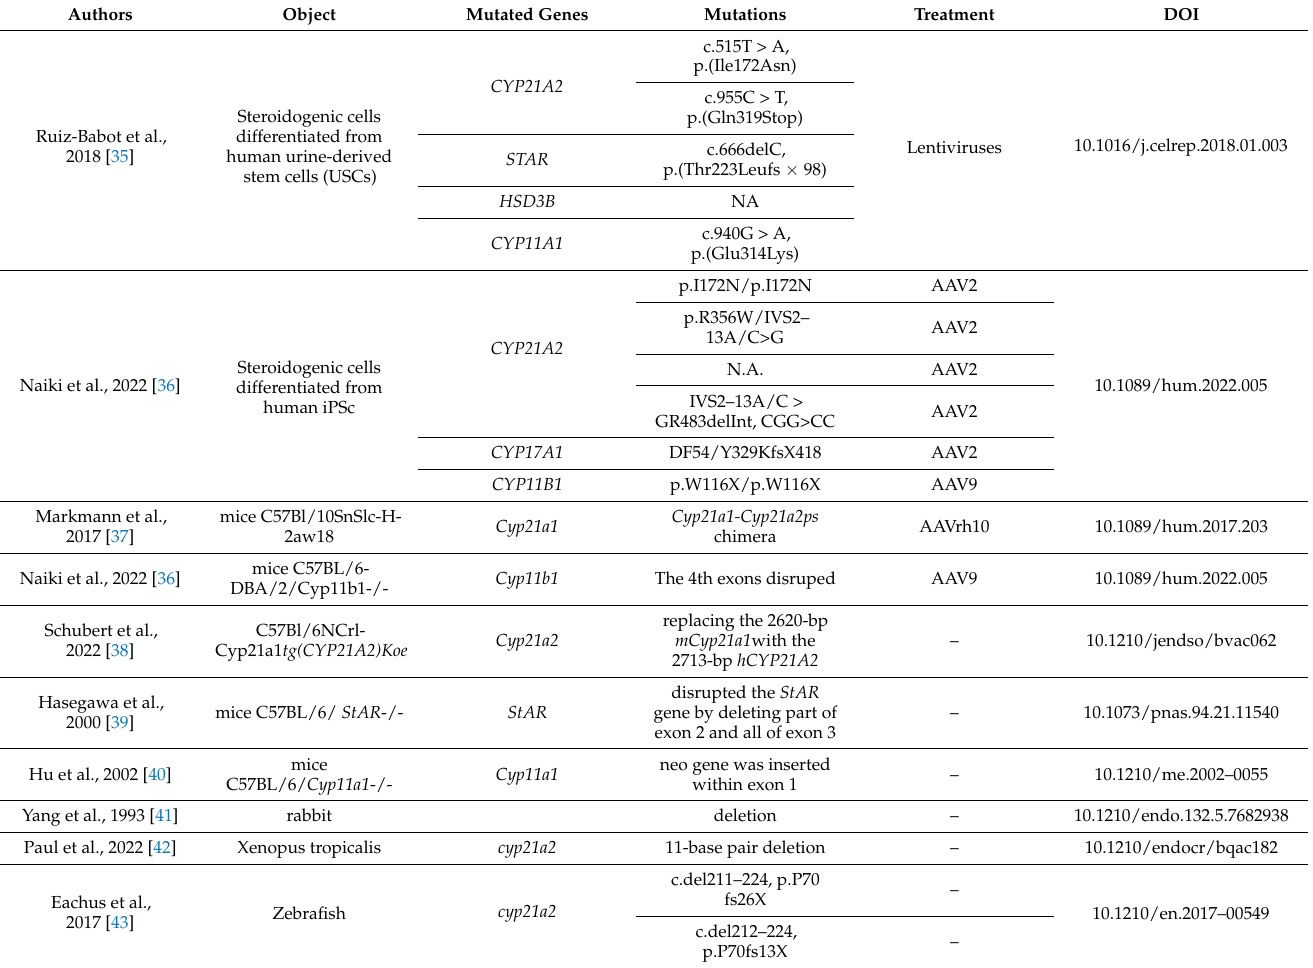
Table 1. Developed CAH